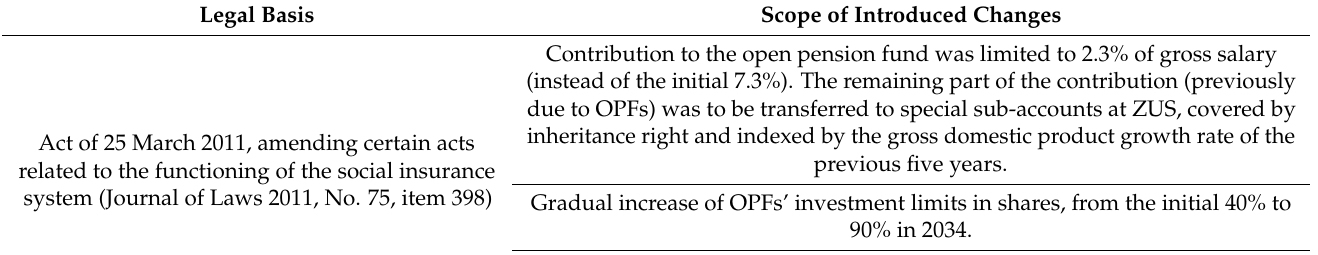
Table A1. The most important statutory changes in the operation of OPFs in